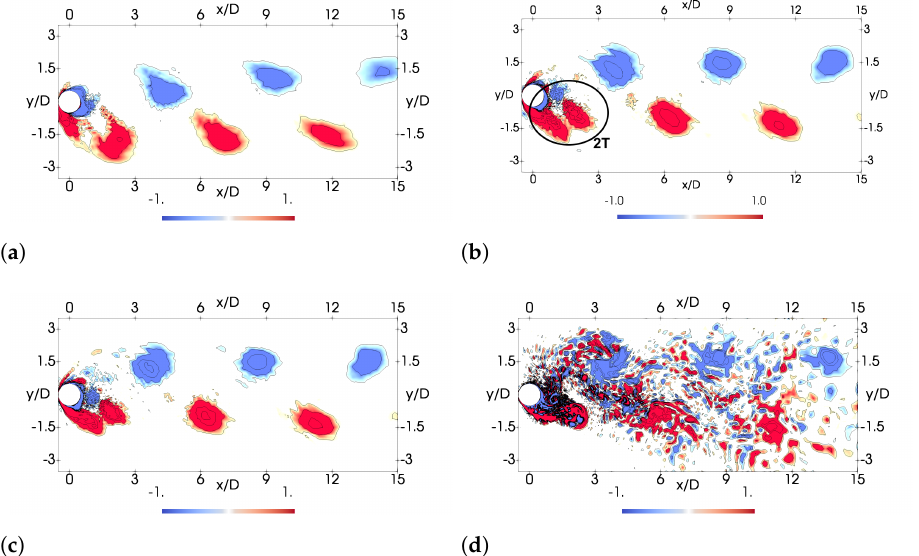
Figure 16. Reconstructed flow: instantaneous span-wise vorticity iso-contours with ( a ) 2 modes, ( b ) 6 modes, ( c ) 10 modes, and ( d ), all